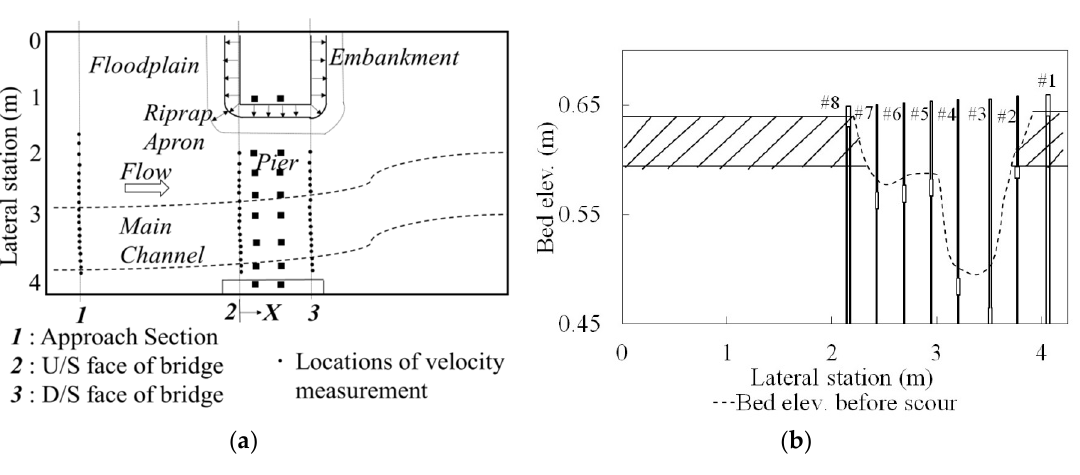
Figure 2. Geometry of compound channel for ( a ) plan view with velocity measurement locations; ( b ) cross section view at bridge.